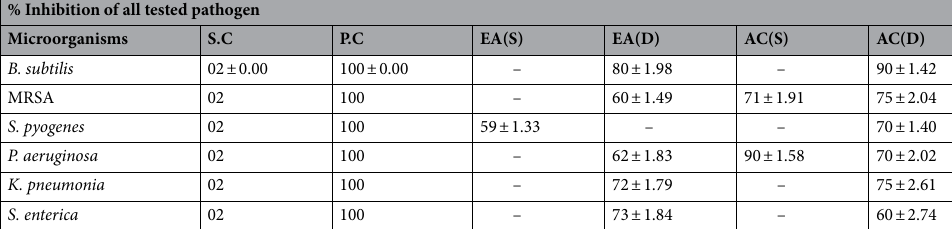
Table 2. Screening of antibacterial effect of sequential and direct extracts by broth dilution method. EA(S): ethyl acetate sequential; AC(S): acetone sequential; EA(D): ethyl acetate direct; AC(D): acetone direct; S.C: solvent control: DMSO (< 1%), P.C: positive control (Gentamicin 10 µg); – : Low activity (less than 50%). The data is expressed as the mean ± standard error of two independent experiments performed in technical triplicates.